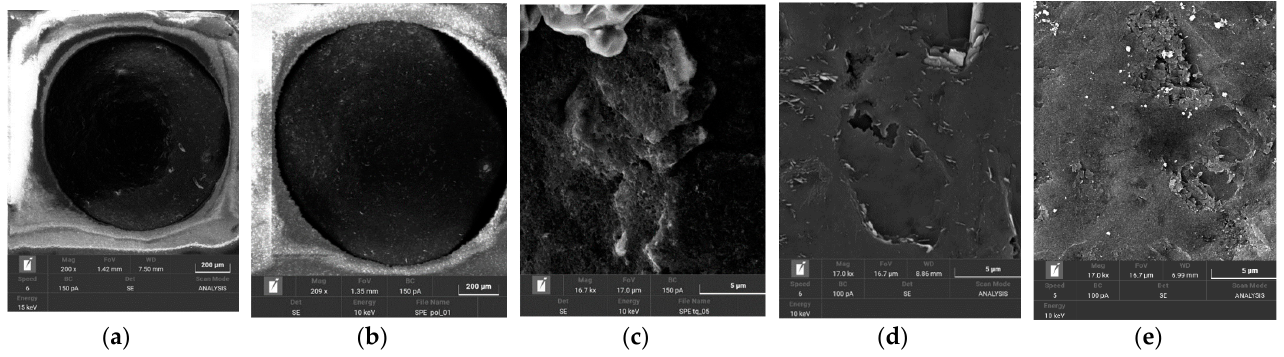
Figure 3. FE-SEM images of the SPCE1 ′ s WE before the polishing procedure ( a , c ), after the polishing procedure ( b , d ), and after the electrochemical activation ( e ). ( a , b ) 10 keV; FOV(Field Of View) = 1.35 µm; ( c – e ) 10 keV; FOV = 17.00 µm.